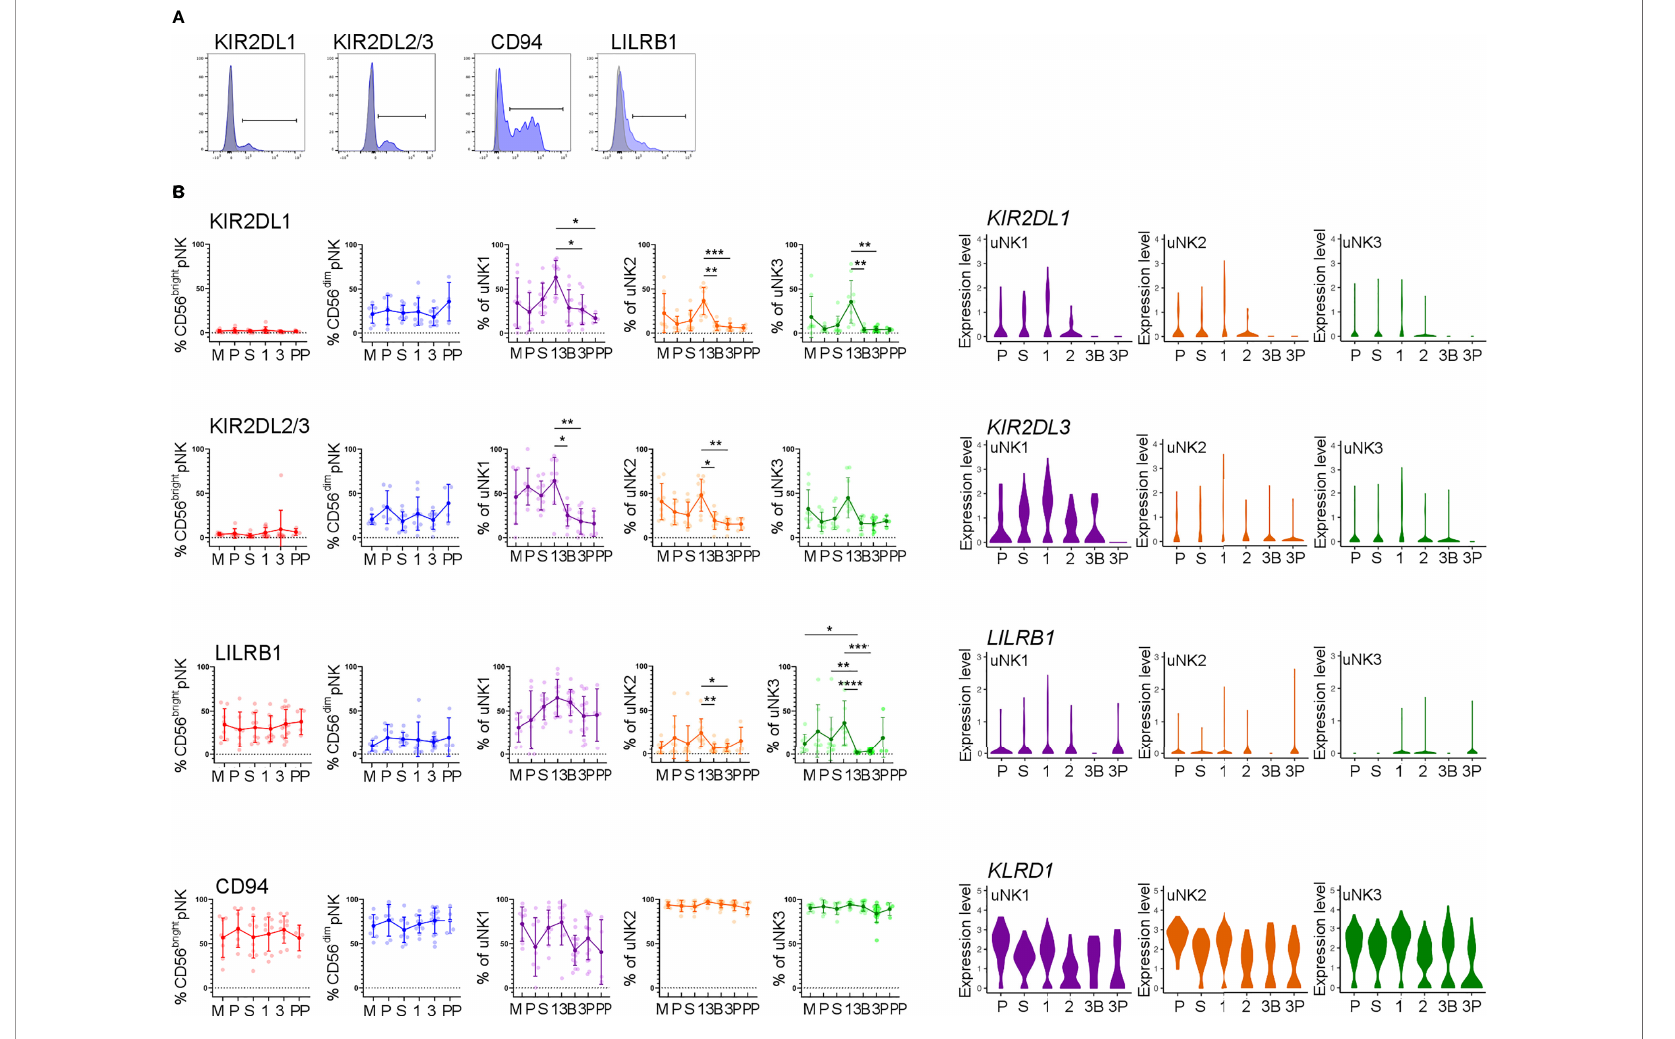
FIGURE 3 | uNK upregulate expression of KIR and LILRB1 in fi rst trimester. (A) Uterine and peripheral NK cells taken at different stages of the reproductive cycle were freshly stained for phenotypic markers. Representative staining from CD56dim pNK is shown in blue alongside FMO controls in grey. (B) Graphs showing frequencies of KIR2DL1, KIR2DL2/3, LILRB1 and CD94 on pNK and uNK subsets. Means and standard deviations are shown for n = 8 (menstrual), n = 7 (proliferative), n = 10 (secretory) n= 10 ( fi rst trimester), n= 16 (third trimester decidua basalis), n = 16 (third trimester decidua parietalis), n = 4 (postpartum). Statistical testing was done using Kruskal Wallis with a post-hoc Dunn test *p < 0.05, **p < 0.01, ***p < 0.001, ****p< 0.0001. (C) Violin plots showing corresponding mRNA expression in uNK subsets over the reproductive cycle as determined by scRNAseq. M, menstrual phase; P, proliferative phase; S, secretory phase; 1, fi rst trimester; 2, second trimester; 3, third trimester; 3B, third trimester decidua basalis; 3P, third trimester decidua